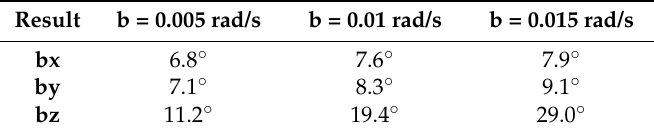
Table 1. RMS errors of the yaw estimation corresponding to different